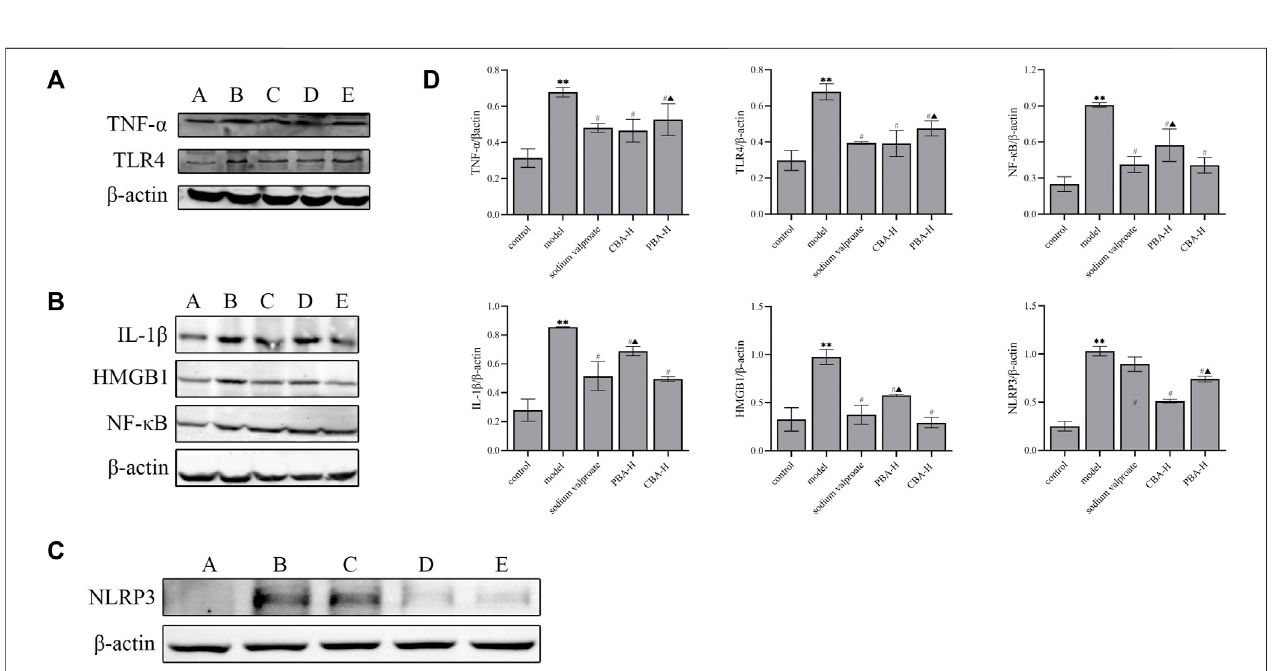
FIGURE5| CBAexertedaneuroprotectiveeffectontheFSmodelbyinhibitingtheactivationofTLR4/NF- κ BandNLRP3in fl ammasomesignalingpathway. (A) The expressionlevelsofTNF- α andTLR4proteinswereanalyzedbyWesternblotting:A)control;B)model;C)FS+sodiumvalproate;D)FS+CBA-H;E)FS+PBA-H. (B) The expressionlevelsofIL-1 β ,HMGB1andNF- κ BproteinswereanalyzedbyWesternblotting:A)control;B)model;C)FS+sodiumvalproate;D)FS+PBA-H;E)FS+CBA- H. (C) TheexpressionlevelofNLRP3proteinwasanalyzedbyWesternblotting:A)control;B)model;C)FS+sodiumvalproate;D)FS+CBA-H;E)FS+PBA-H. (D) The semi-quantitative analysis for Western blotting. Data of relative protein expressions were exhibited as the mean ± SEM. ** p < 0.01 compared to that of the control group; # p < 0.05 compared to that of the model group; ▲ p < 0.05 compared to that of the CBA-H group.